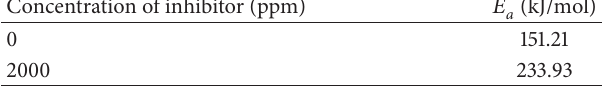
Table 3: Activation energy value.